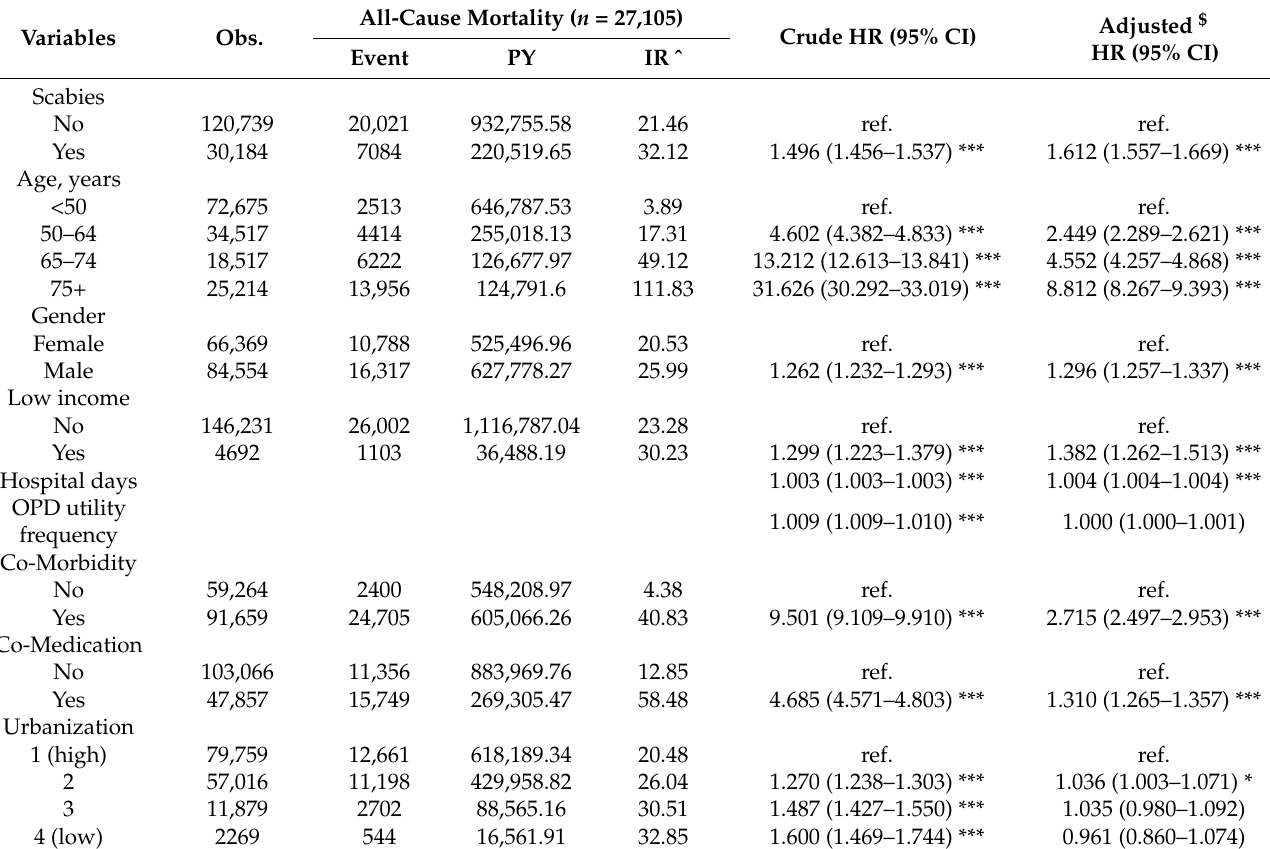
Table 3. HRs and 95% CIs of all-cause mortality associated with scabies and other covariates.